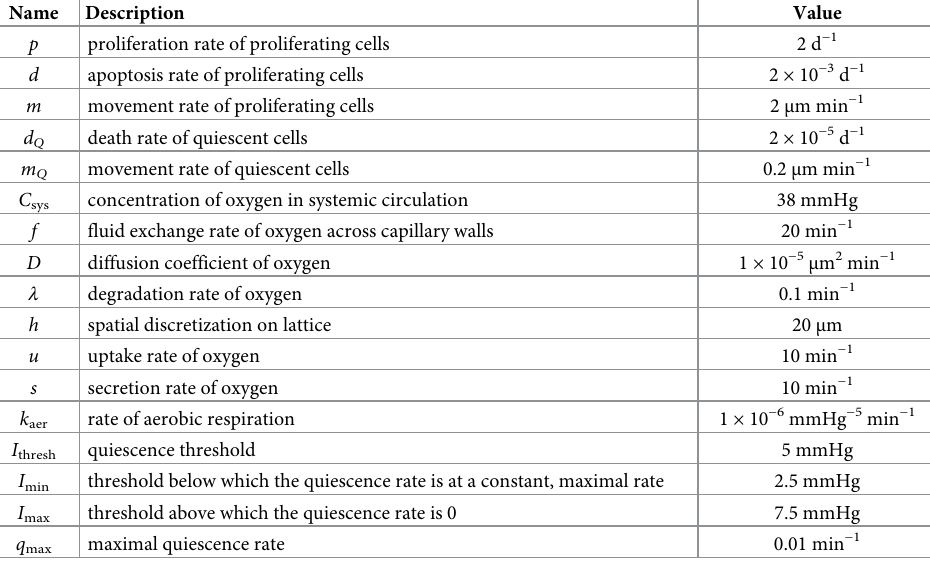
Table 1. Parameter values. Values are calibrated within biological ranges to produce both normoxic and hypoxic regions within the